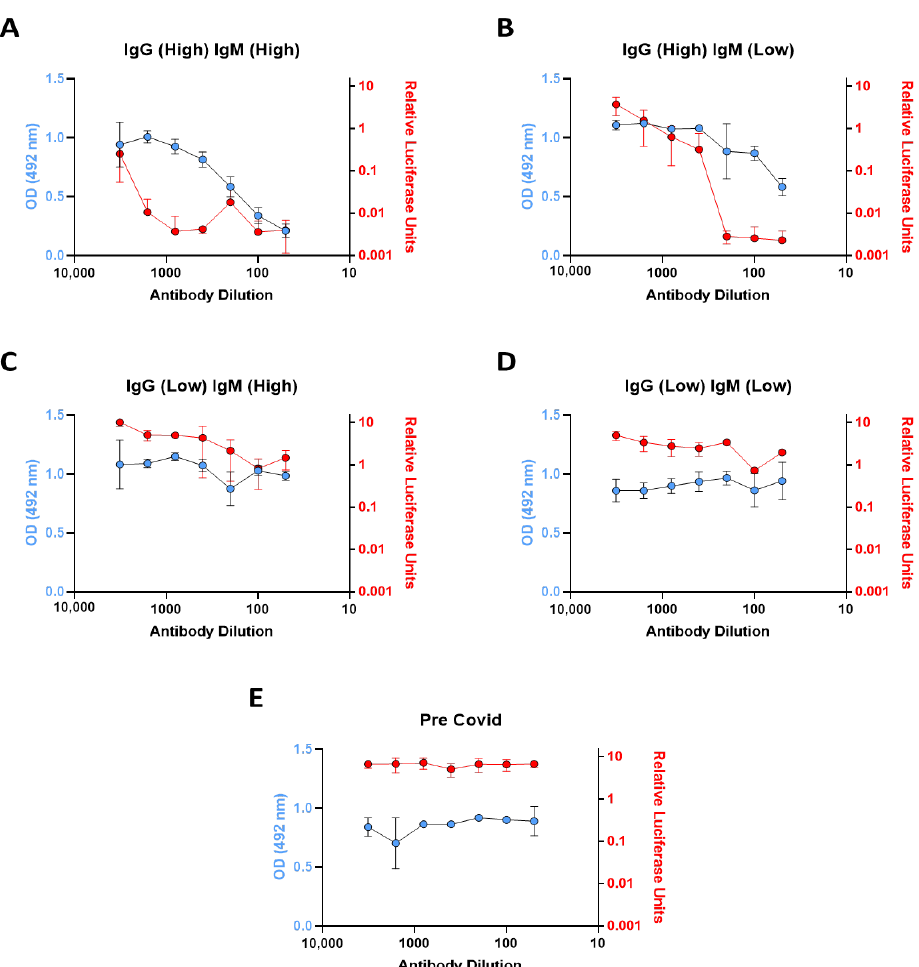
Figure 4. Antibody spike RBD neutralization capacity in patient sera with different immunoglobulin profiles. ( A – E ) Demonstrates the spike RBD neutralization capacity of patients with various immunoglobulin profiles using serially diluted serum. The blue points represent the data generated using the in vitro ACE2 binding assay and the red points represent data generated from the same sample using the pseudovirus assay. Data are the mean ± the standard deviation of triplicate samples from a representative experiment ( n = 3).